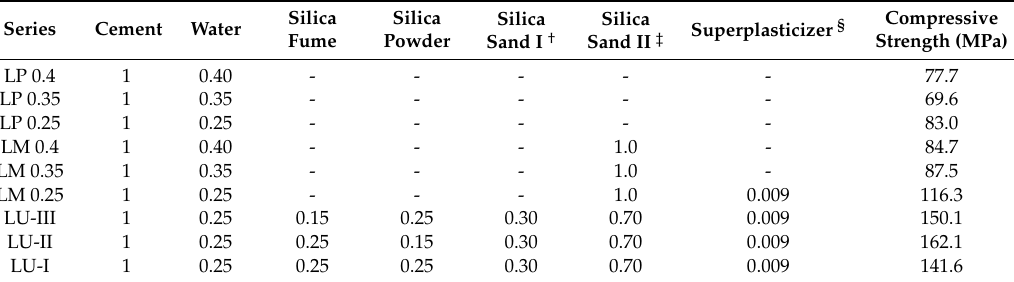
Table 1. Cement-based materials mixing design (proportion by